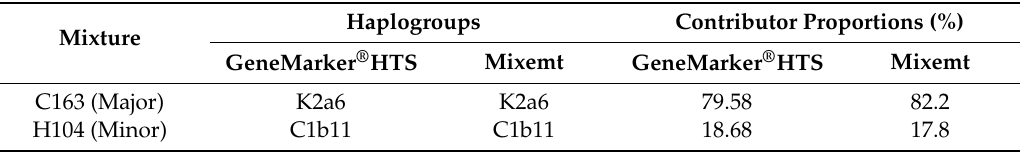
Table 6. Haplogroup determination and contributor proportions estimation for a contrived 80:20 mixture using GeneMarker ® HTS and Mixemt